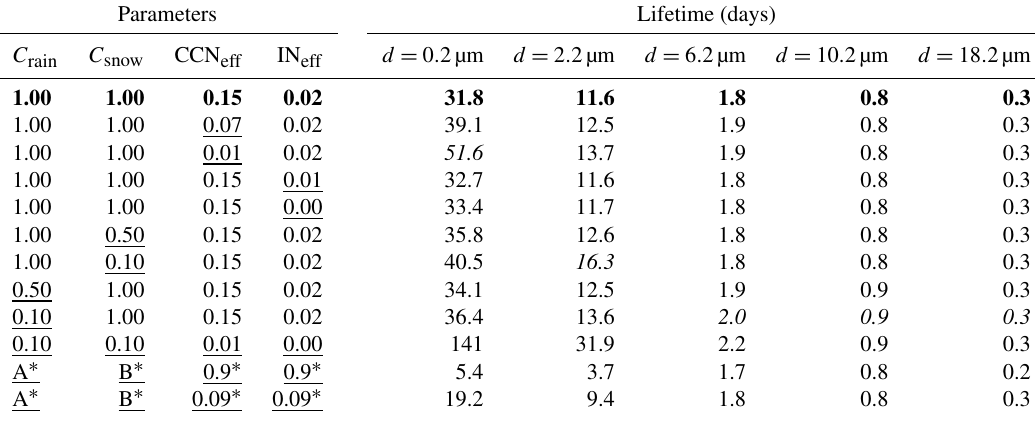
Table 2. Sensitivity analysis of lifetimes τ F for dust particles of different sizes (diameter d ) and with different settings of the removal parameters. Bold values: default parameter settings, italicised values: the longest lifetime if only one deposition process is reduced and underlined values: the changed parameter(s) relative to the default settings. The last two rows, denoted by “ ∗ ”, reports results obtained with FLEXPART v9 with the old removal scheme, where below cloud scavenging was parameterized as (cid:51) = AI B , with A = 1 e − 4 and B = 0 .